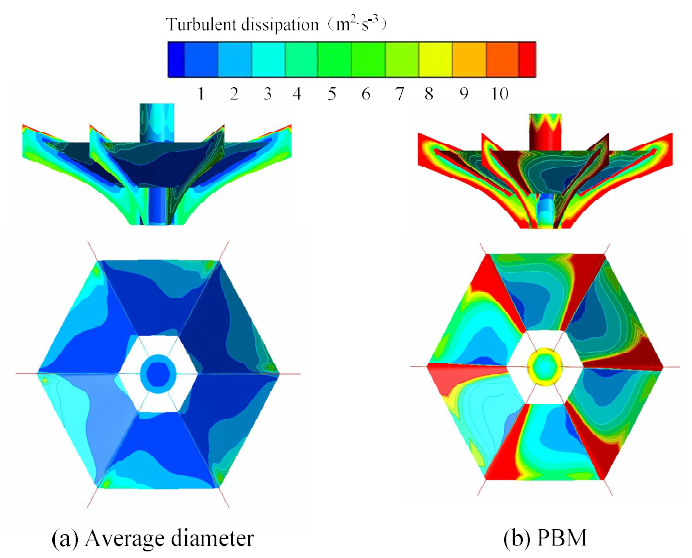
Figure 11. Distribution of turbulent dissipation rate. ( a ) Average diameter, ( b ) PBM.